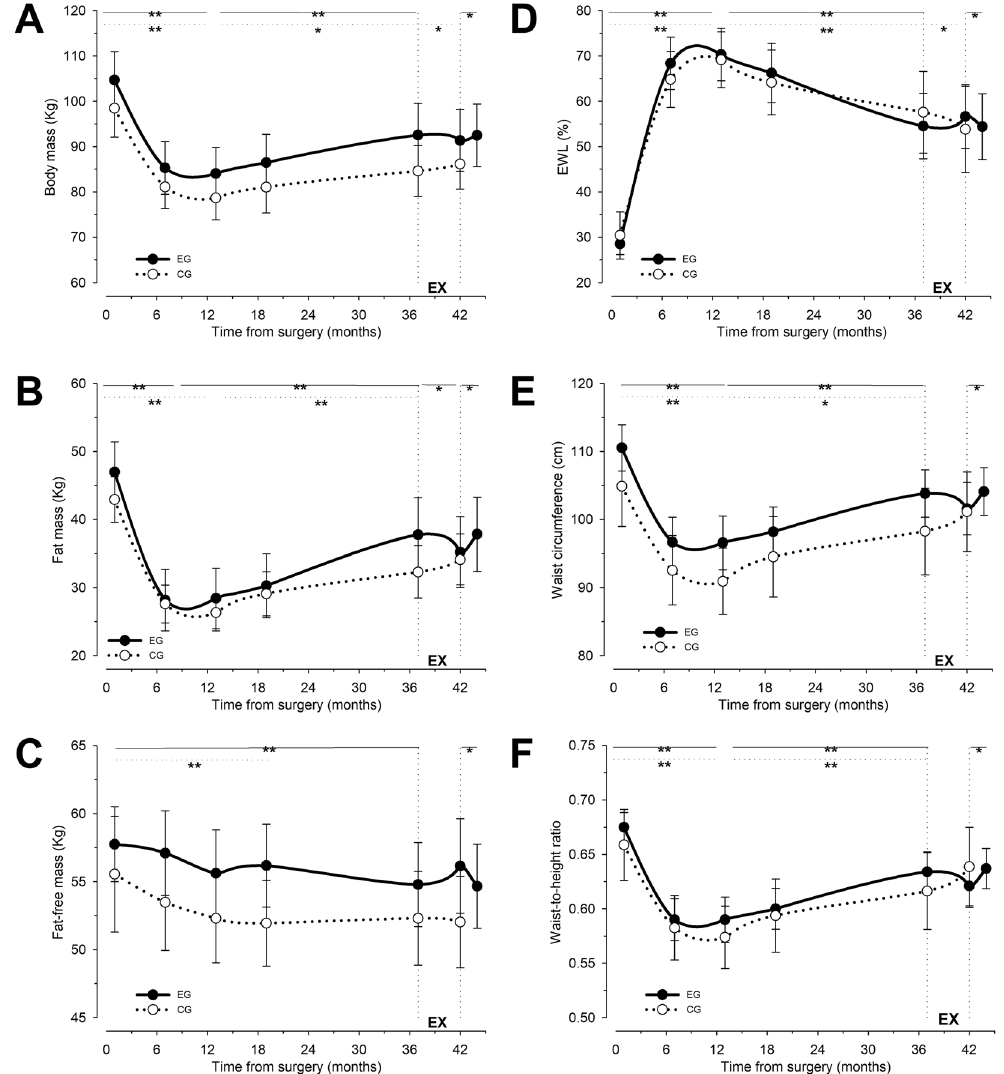
Figure 2. Changes in body mass ( A ), fat mass ( B ), fat-free mass ( C ), excess weight loss ( D ), waist circumference ( E ) and waist to height ratio ( F ) during the follow-up. The vertical dotted lines at 37 and 42 weeks mark the 5-month exercise intervention (EX). Data represent mean ± SEM. Data for the experimental group (EG) are indicated as black dots and continuous lines. Data for the control group (CG) are indicated as open dots and dotted lines. Statistical comparisons correspond to intragroup t-tests among the indicated time points. Horizontal continuous lines indicate the time points compared in the EG, while horizontal dotted lines indicate the time points compared in the CG. * p < 0.05; ** p < 0.01. At the beginning of the intervention (EX) body mass ( A ) was significantly higher than after surgery, and this was due to the regain of fat mass ( B ) and a trend to lose fat-free mas ( C ). Consequently, at the beginning of the intervention a significant reduction of excess weight loss ( D ) was observed in both groups in comparison with its maximal value, reached approximately one year after surgery. This was accompanied by an increase of various cardiovascular risk factor ( E,F ). In the EG the intervention contributed to counteract the progressive increase in fat mass ( B ) and the decline in EWL ( D ) seen in the CG. Body mass was not significantly reduced during the intervention in the EG ( A ), possibly due to the trend to increasing the fat-free mass in this group caused by the intervention ( C ). Similarly, the intervention tended to improve the cardiovascular risk factors in the EG ( E,F ). All of these effects seem to be caused directly by the exercise program, since they significantly varied in the opposite direction in the retention evaluation, two months after ending the